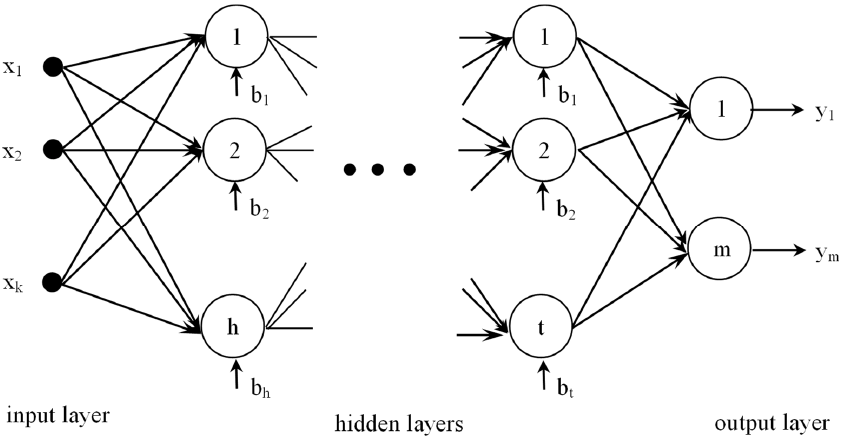
Figure 2. Multilayer feed-forward NN